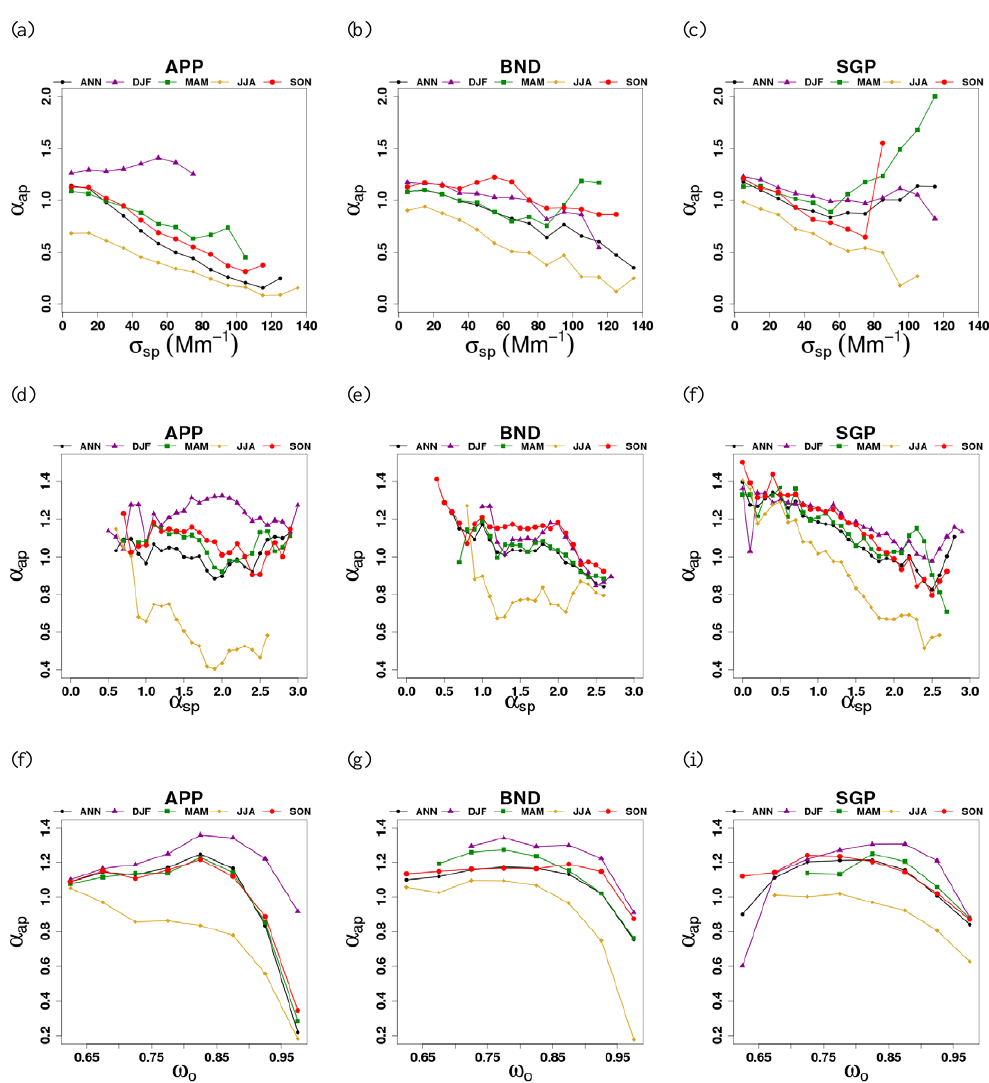
Figure 11. Systematic relationships among mean AOPs involving PM 1 absorption Ångström exponent ( α ap ) for individual seasons of the 2010–2013 period at APP, BND, and SGP: (a) α ap vs. σ sp at APP; (b) α ap vs. σ sp at BND; (c) α ap vs. σ sp at SGP; (d) α ap vs. α sp at APP; (e) α ap vs. α sp at BND; (f) α ap vs. α sp at SGP; (g) α ap vs. ω 0 at APP; (h) α ap vs. ω 0 at BND; (i) α ap vs. ω 0 at